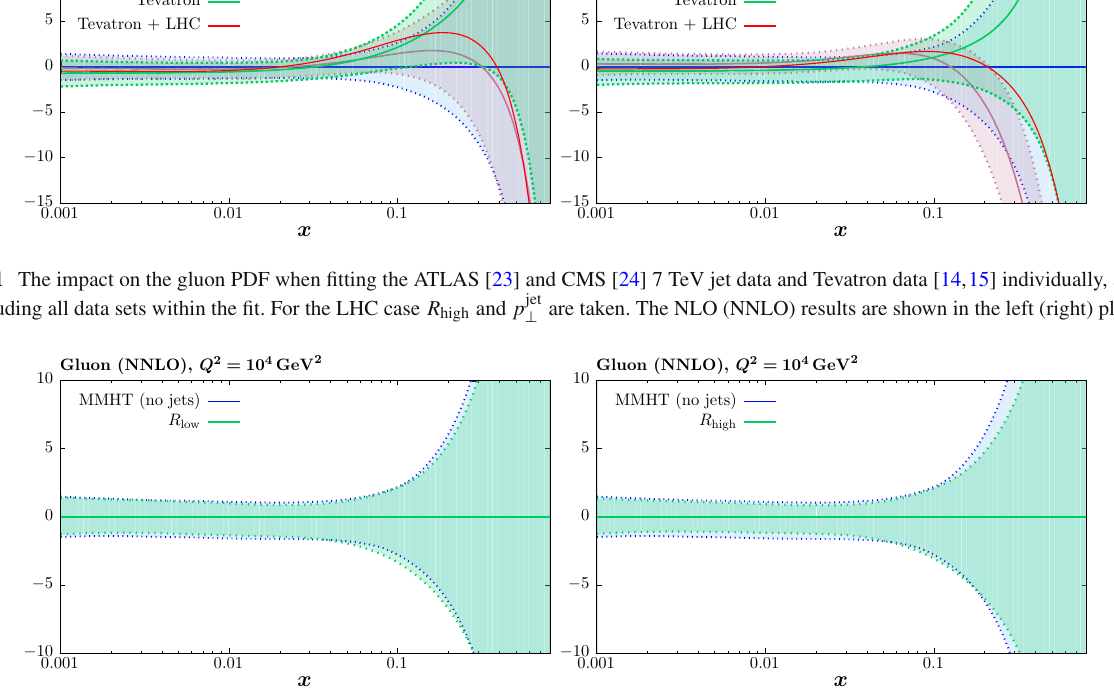
fit, with no jet data included, given for comparison. The left (right) plots correspond to the for ‘low’ and ‘high’ jet radii described in the text